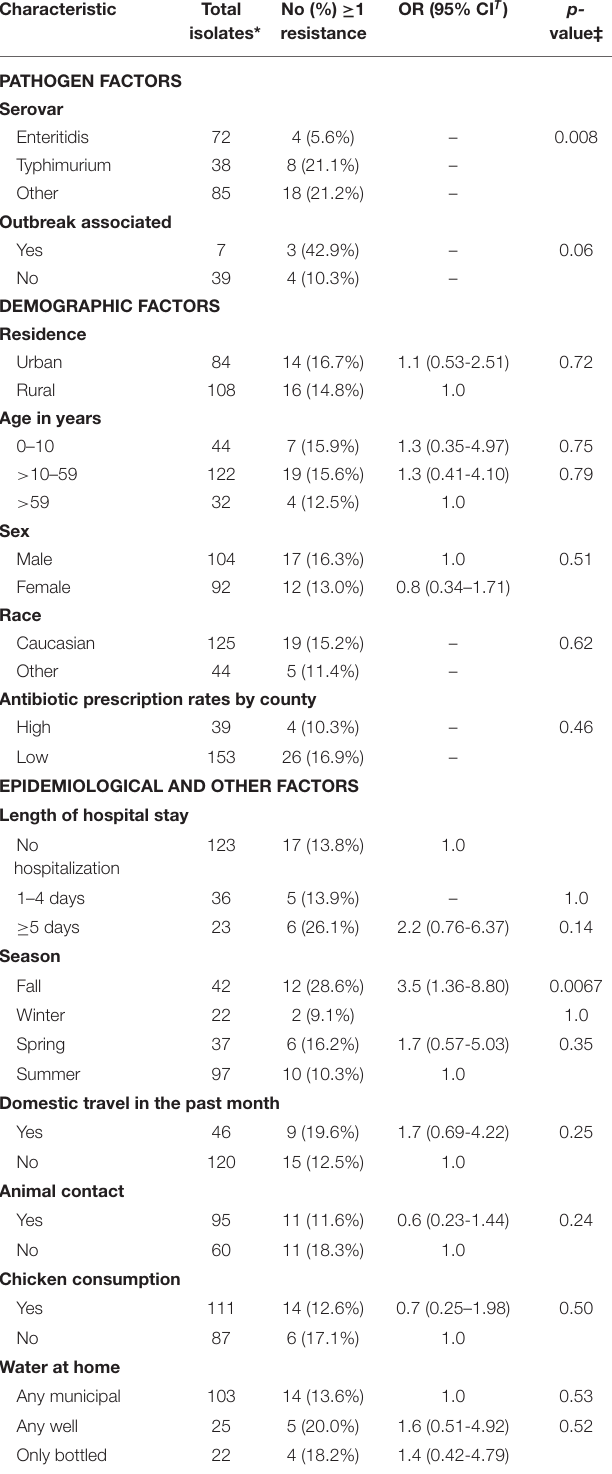
TABLE 1 | Univariate and multivariate analysis to identify factors associated with antibiotic resistance in 198 clinical non-typhoidal Salmonella in Michigan, 2011–2014. Characteristic